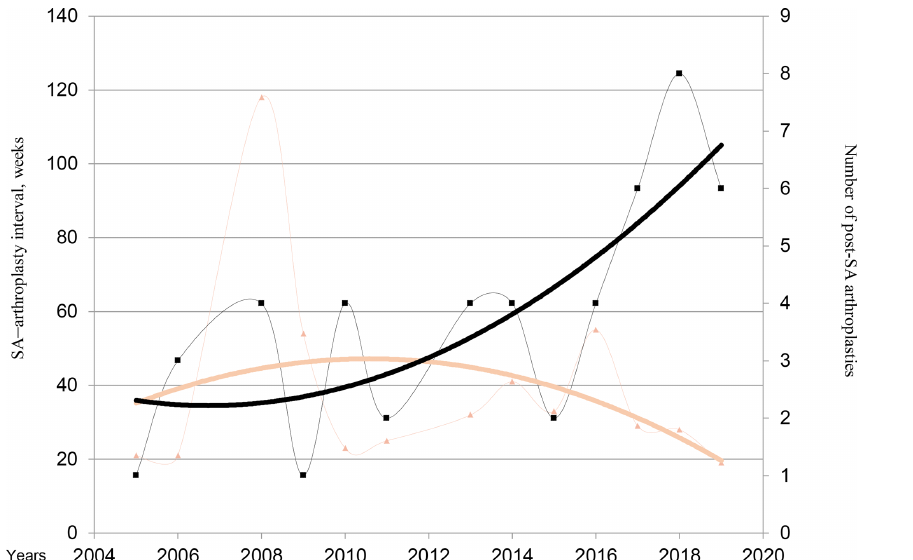
Figure 1. Evolution of the numbers of hip and knee replacements after septic arthritis (SA). Brown triangles and brown line (trend line) represent the median SA–arthroplasty interval. Black square and black line (trend line) represent the number of post-SA arthroplasties per